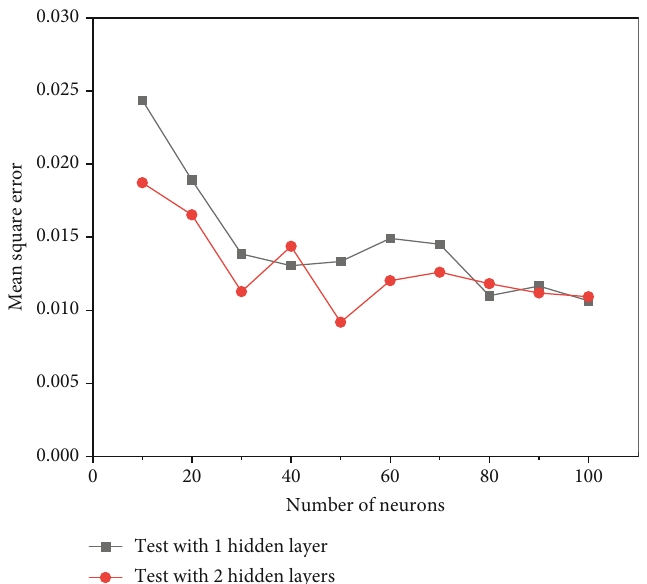
Figure 10: The MSE of an ANN model with di ff erent neurons and hidden layers (using the logistic Sigmoid